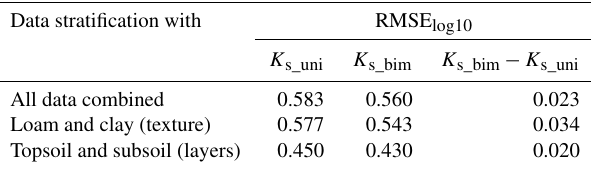
Table 5. The RMSE log10 reported by using K s_bim and K s_uni models, by stratifying the data with/without texture and layers.